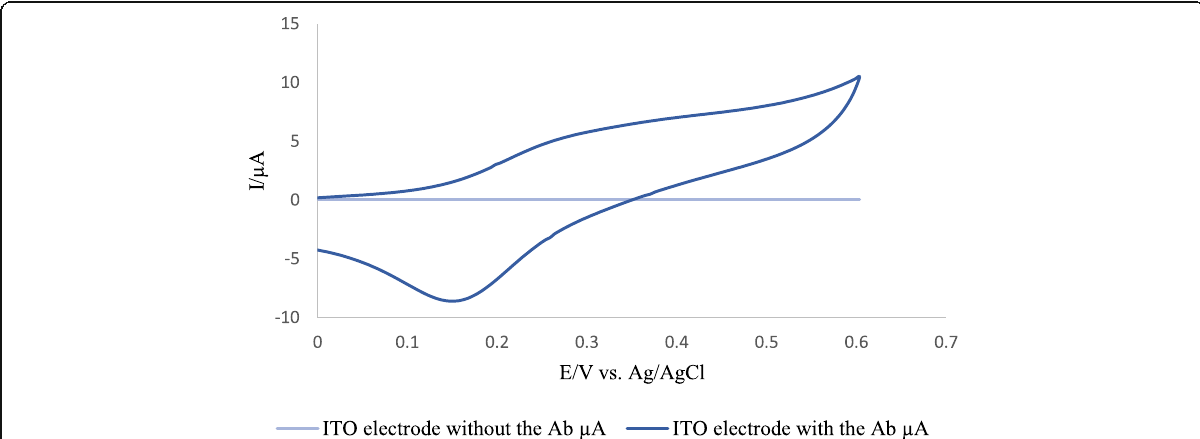
Fig. 1 Cyclic voltammogram of the modified ITO electrode surface with and without the tagged ferrocene antibody. Scan rate 100 mV s − 1 . Ten millimolar PBS was the solution used to conduct all the experiments